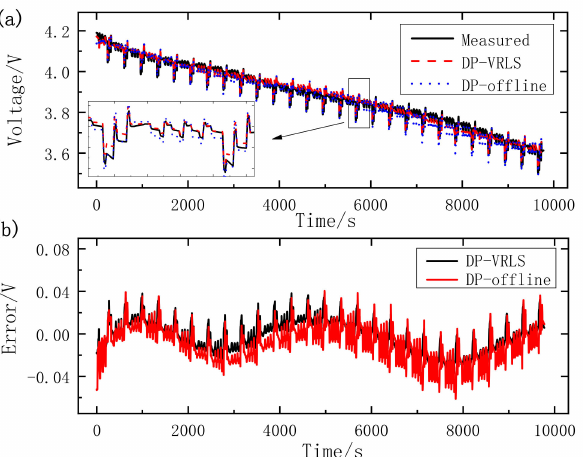
Figure 7. The estimated terminal voltage and corresponding errors based on different battery parameter identification under DST condition: ( a ) voltage comparison; ( b ) error of